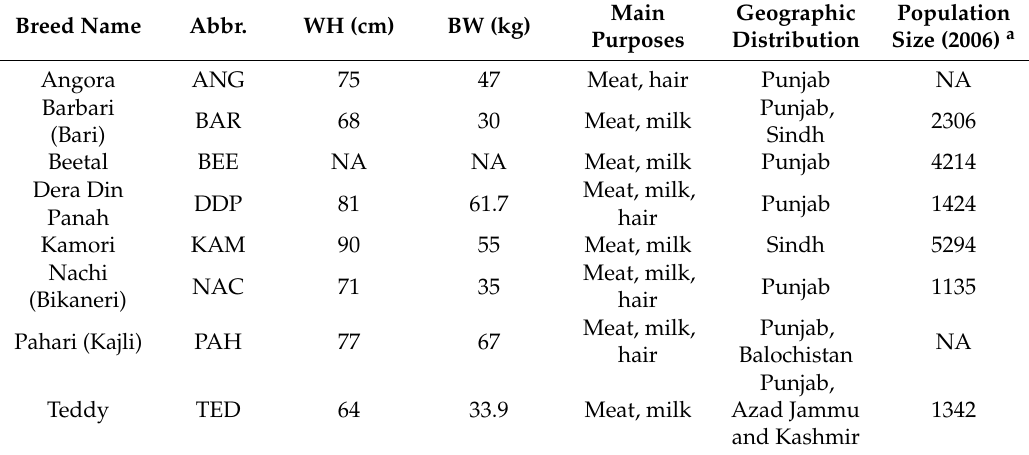
Table 1. Phenotypic characteristics of eight goat breeds of